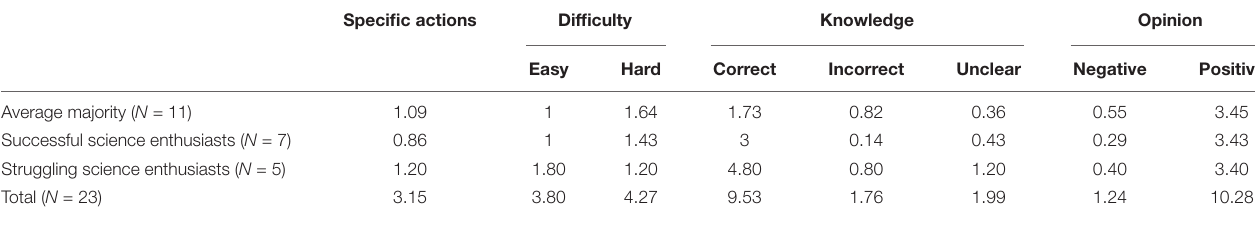
TABLE 7 | Code frequencies of the code groups per profile, divided by the profile sample size, for lesson 2